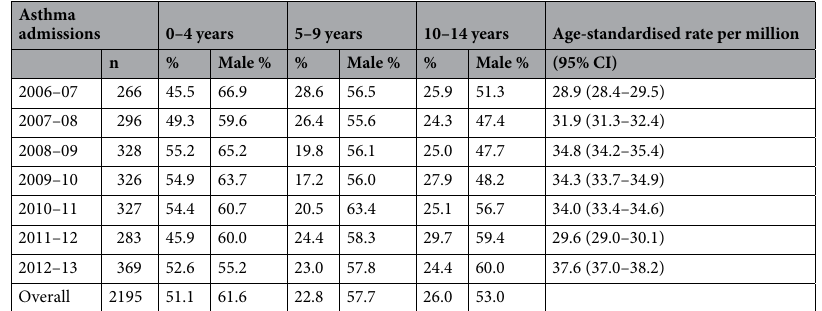
Table 1. Admissions with asthma as the primary reason for admission in PICU in England with percentages by age-groups and males therein and age-standardised rate per million [number (n), percentages (%) and 95% confidence interval (95%